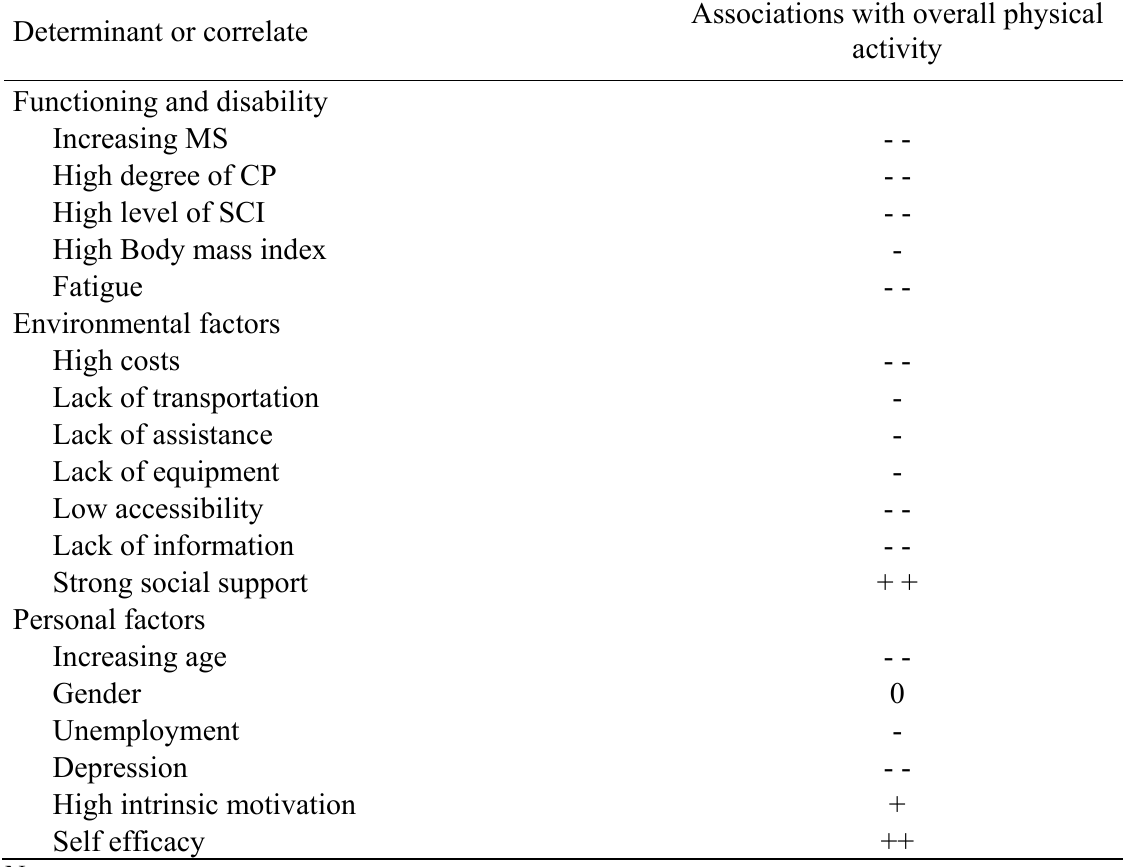
Table 3. Correlates of physical activity in adults with disabilities Determinant or